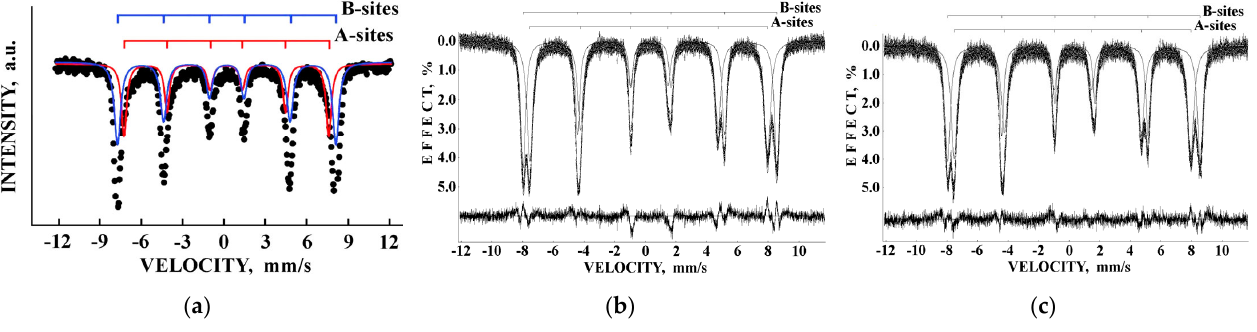
Figure 49. Room temperature Mössbauer spectra of NiFe 2 O 4 nanoparticles measured with a low velocity resolution ( a ) and with a high velocity resolution: NA ( b ) and NB ( c ), adapted from Ref. [79] with permission from Elsevier: Materials Chemistry and Physics, Vol. 202, Ushakov M.V.,